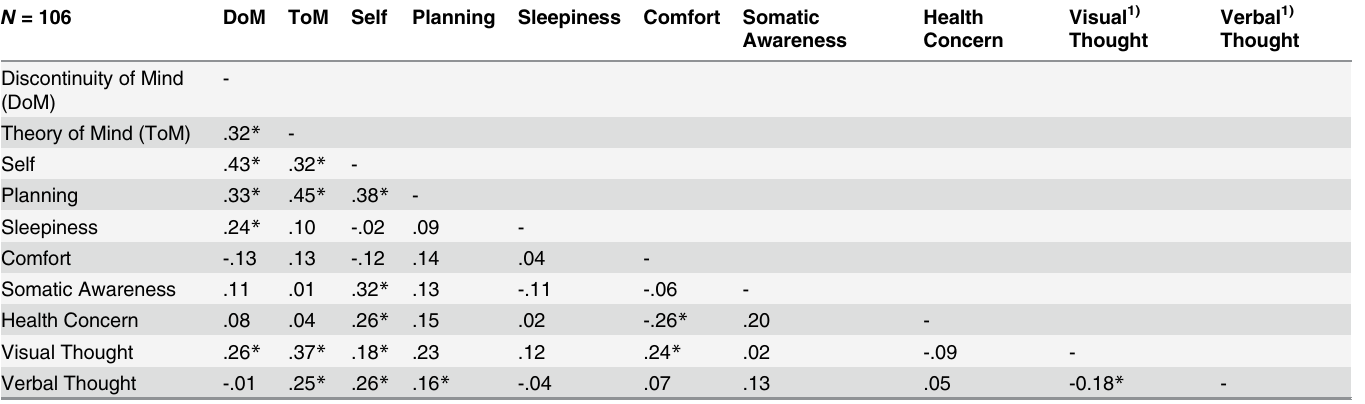
Table 1. Interfactor correlation matrix of ARSQ dimensions (Pearson